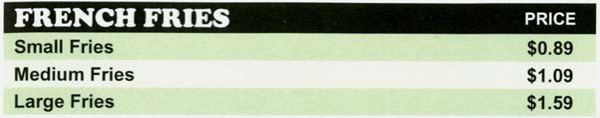
Excerpt from control menu.